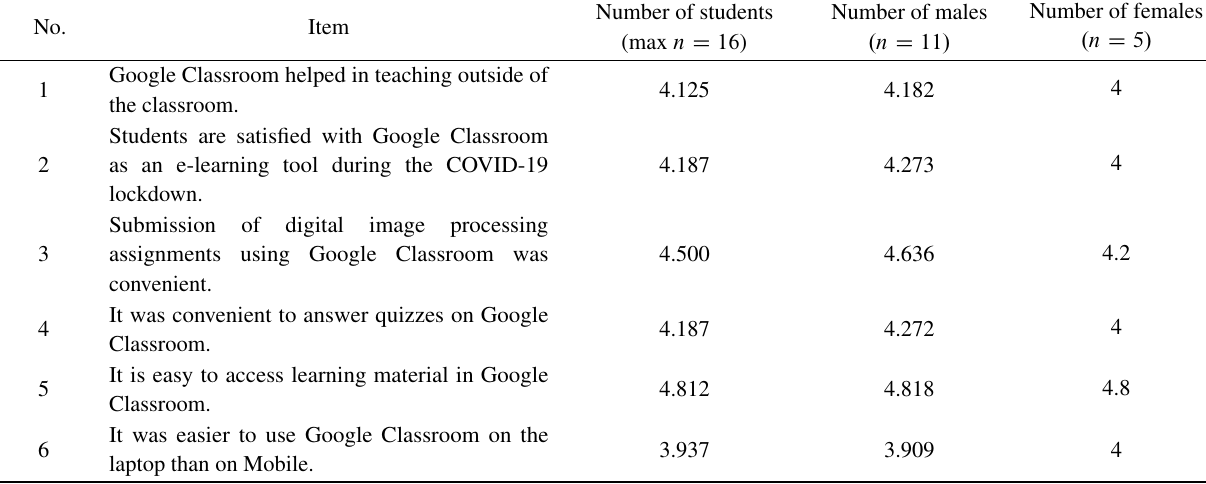
Table 3 Students’ response to survey conducted regarding Google Classroom practices adopted by teaching faculty of National Institute of Technology, Hamirpur on a scale of 1– 5, with five being maximum. The values are averaged. No.